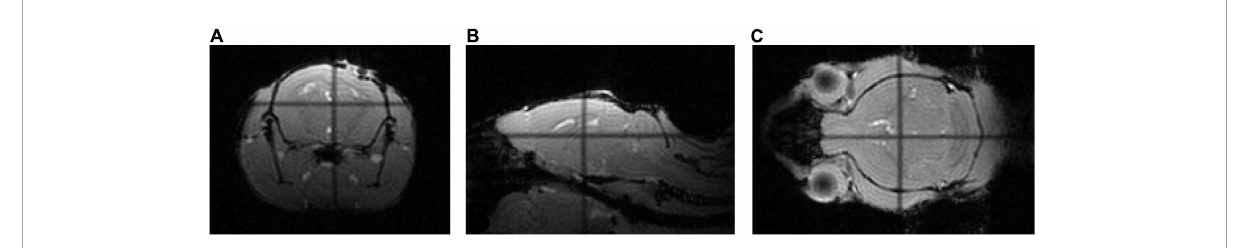
FIGURE5 MRI localizer images. (A–C) Coronal, sagittal, and axial GE images acquired through a localizer scan show little to no distortion around the